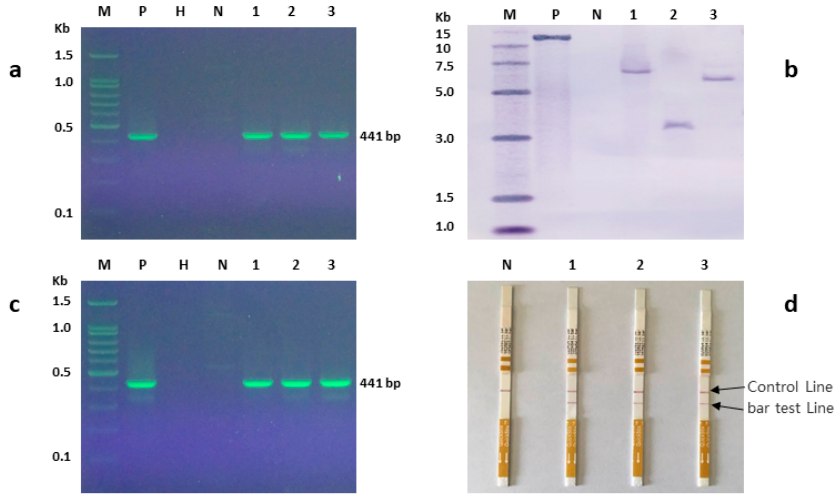
Figure 6. Molecular analysis of Veratrum dahuricum regarding bar (phosphinothricin acetyl transferase) gene. M: DNA molecular weight marker, P: positive control of plasmid pCAMBIA3300-35S-bar, H: negative water control, N: non-transformed control plant, 1–3: transgenic plants ( a ) PCR analysis showing the expected 441 bp band in the positive control and transgenic plants 1–3; ( b ) Southern blot analysis showing the single hybridized band in the positive control and transgenic plants 1–3. Plant genomic DNA and plasmid were digested with EcoR I and hybridized with digoxigenin (DIG) labelled bar probe. ( c ) Expression analysis of bar gene in transgenic plants by RT-PCR using bar gene primers. The expected 441 bp band is visible in the positive control and transgenic plants 1–3; ( d ) Bar protein expression analysis by ENVIROLOGIX quick stick kit for LibertyLink (bar). Transgenic plants 1–3 showing BAR.